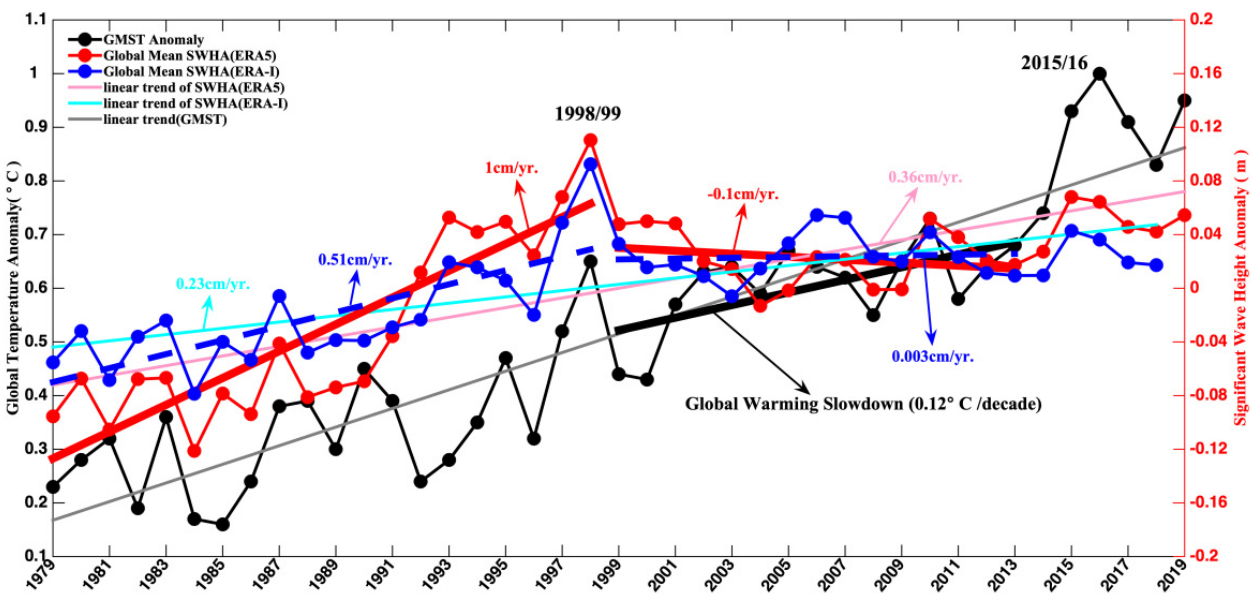
Figure 1. Significant wave height annual anomalies (with respect to the 1979 – 2019 average of 2.47 m) averaged over the global oceans using ERA5 reanalysis data (solid red line; units: m), (with respect to the 1979 – 2018 average of 2.36 m) from ERA-Interim reanalysis data (solid blue line) and global mean surface temperature with respect to the 1981 – 2010 average (solid black line; units: °C). The blue dotted line is the linear trend of global SWH anomalies. The two thick red lines (ERA5) and two blue dotted lines (ERA-Interim) represent the slopes of global SWH anomalies during 1979 – 1998 and 1999 – 2013, respectively. The thick black line is the slope of the global mean surface temperature during the global warming slowdown period. The years corresponding to strong El-Niño events in 1998/99 and 2015/16 are annotated on the graph. The solid lines represent the linear trends of SWHA from ERA5 (light red), SWHA from ERA-Interim (light blue) and global mean surface temperature from NOAA (grey).